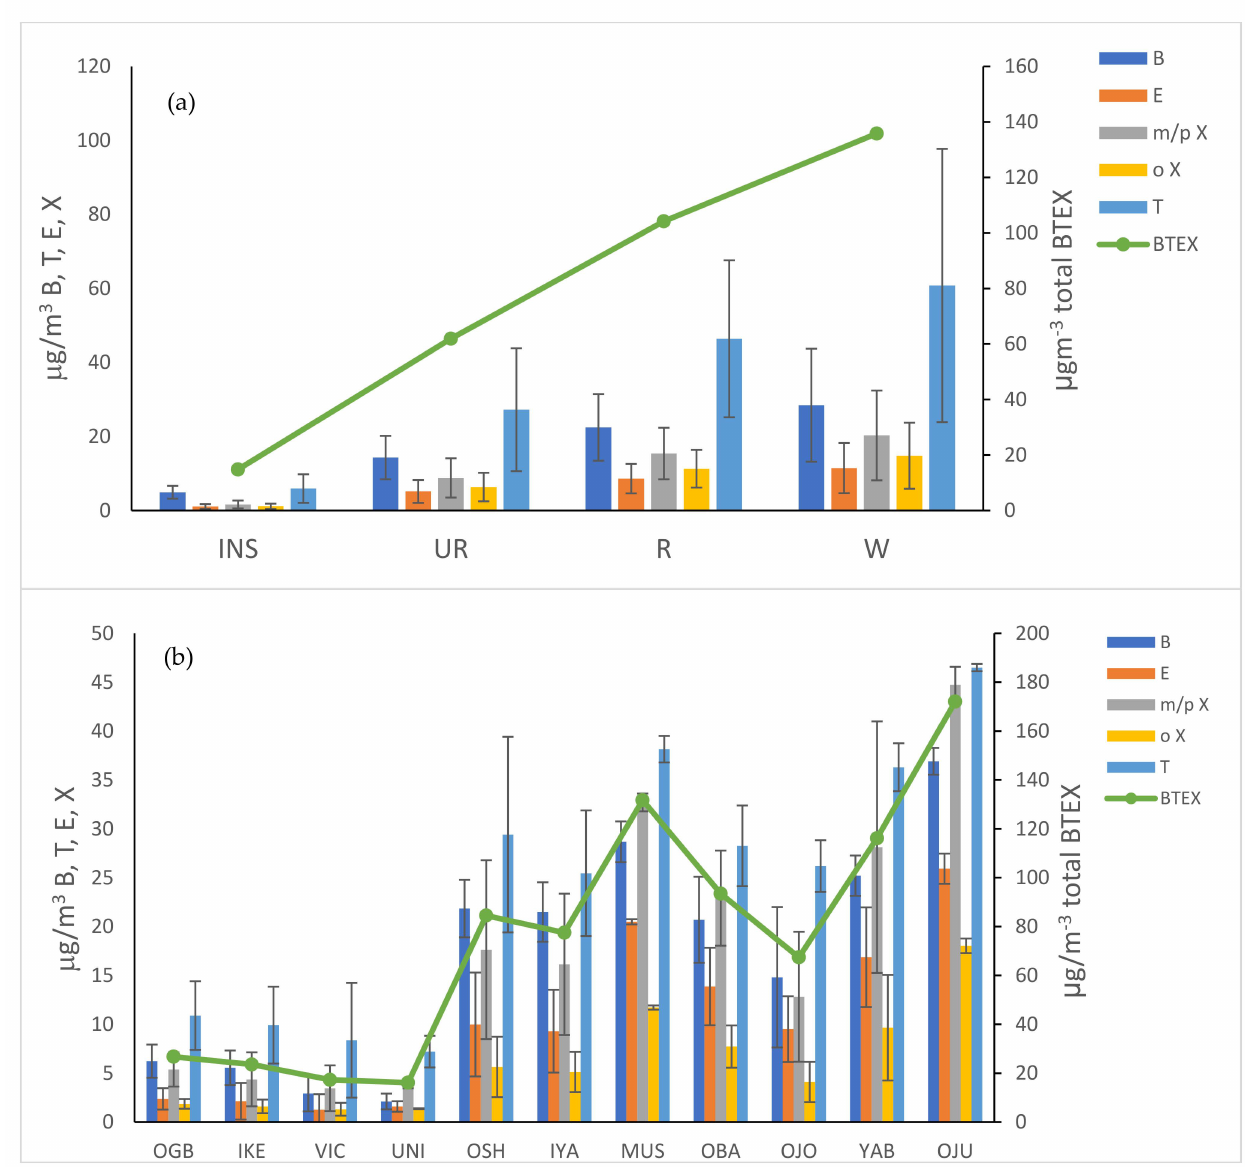
Figure 6. Concentrations of BTEX compounds across site measured in ( a ) Nairobi and ( b )